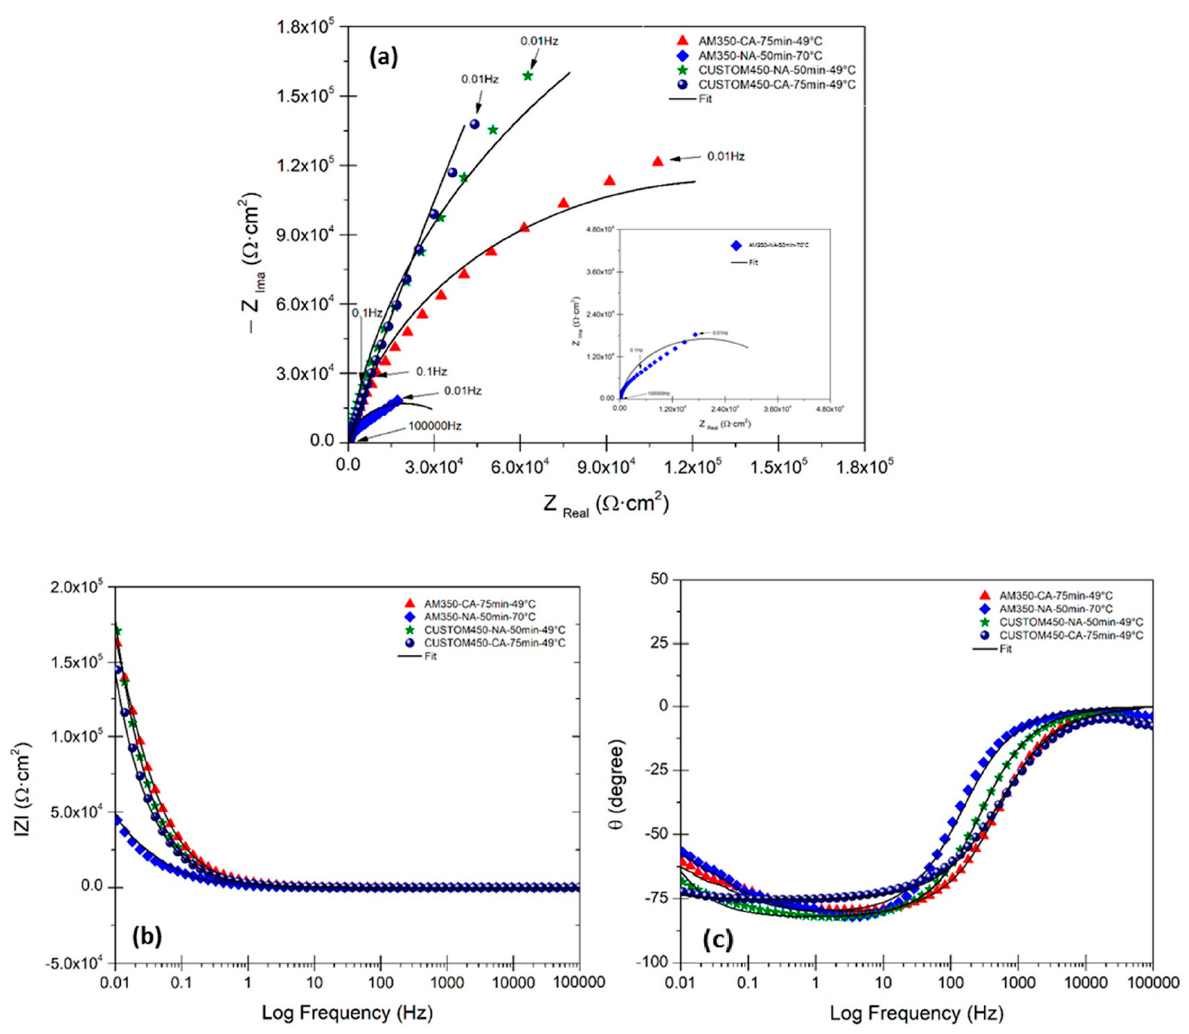
Figure 6. Nyquist ( a ) and Bode ( b , c ) plots of CUSTOM 450 and AM 350 passivated stainless steels immersed to 1 wt. % H 2 SO 4